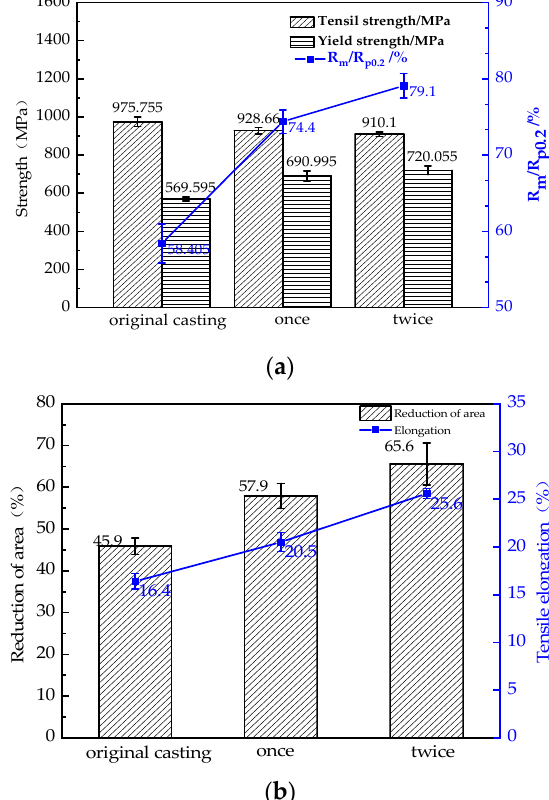
Figure 8. Relationship between tensile properties and number of repairs. ( a ) Tensile strength, yield strength, yield strength ratio. ( b ) The shrinkage and elongation of sections.